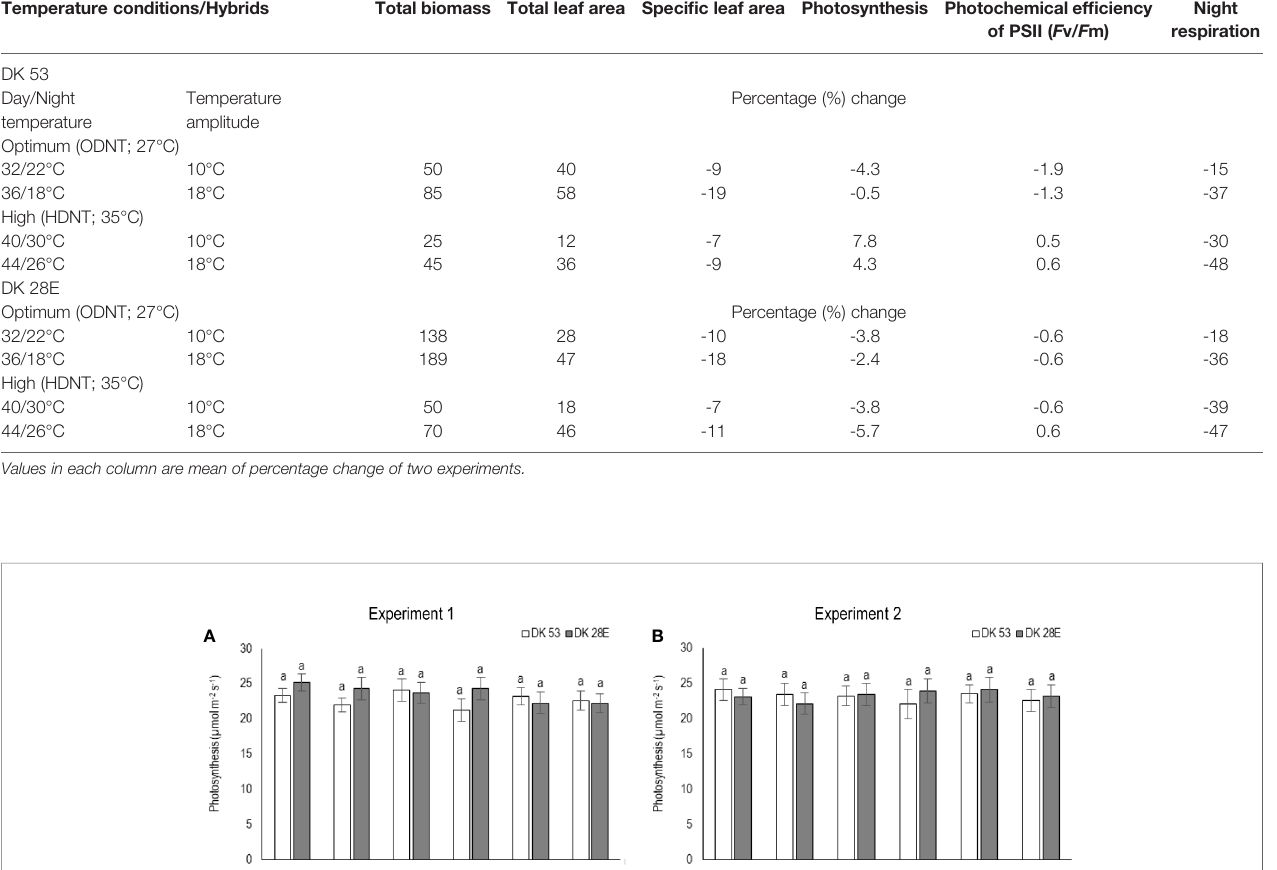
TABLE 3 | Percentage change in growth and carbon tradeoff in two sorghum hybrids (DK 53 and DK 28E) under diurnal temperature amplitutes of 10°C and 18°C compared to narrow diurnal temperature ampltude of 2°C with two mean temperatures [27°C (optimum mean daytime and nighttime temperature; ODNT) and 35°C (high mean daytime and nighttime temperature; HDNT)].